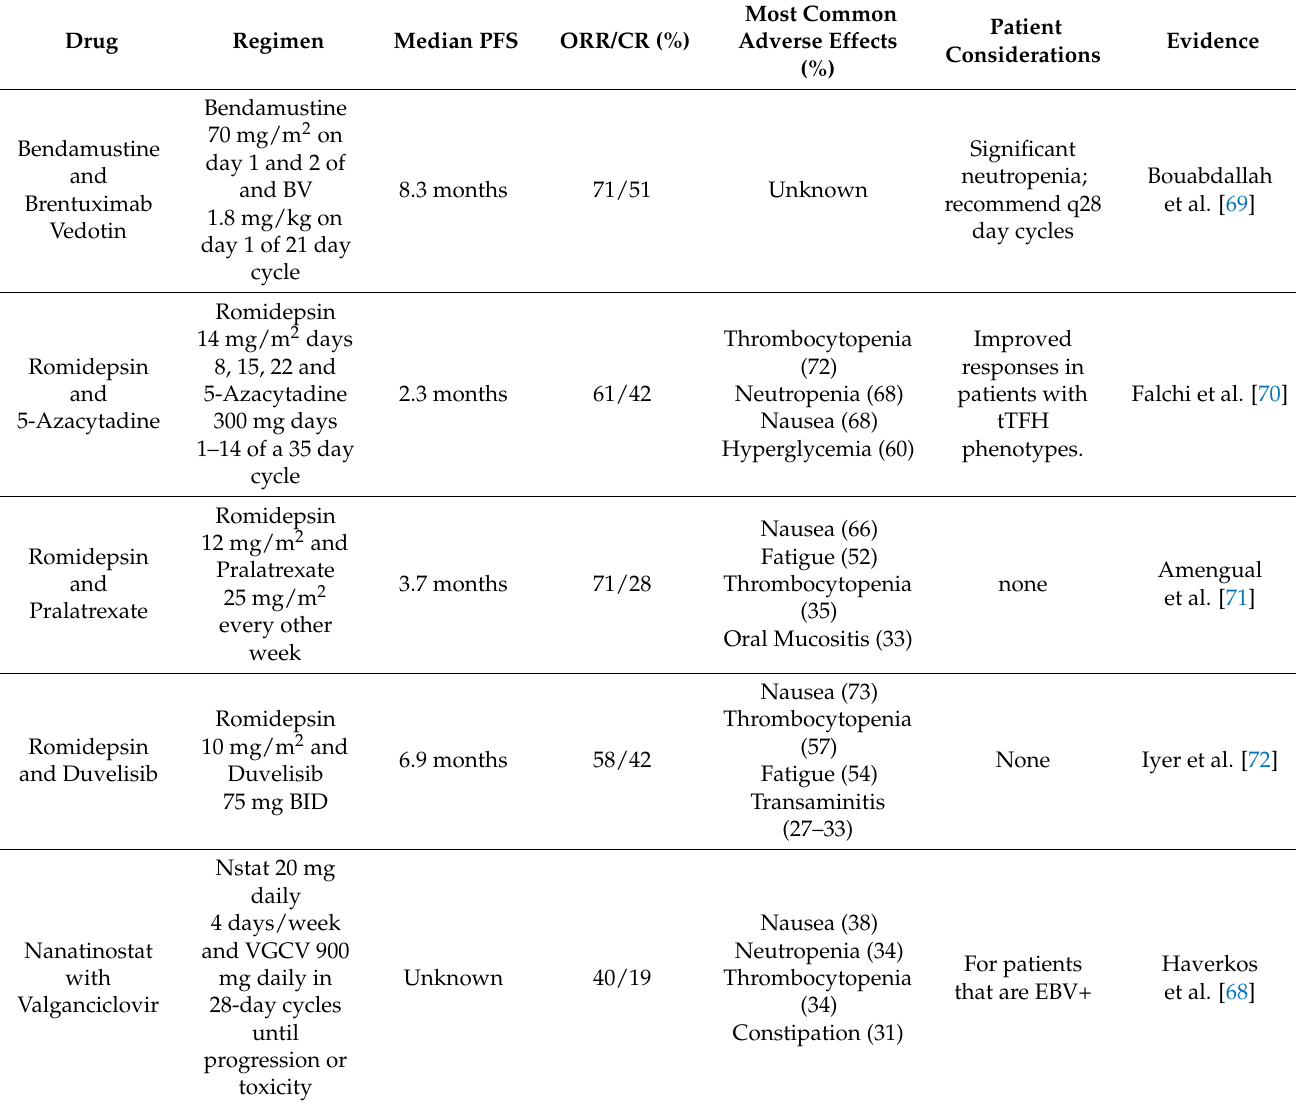
Table 4. Combination Investigational